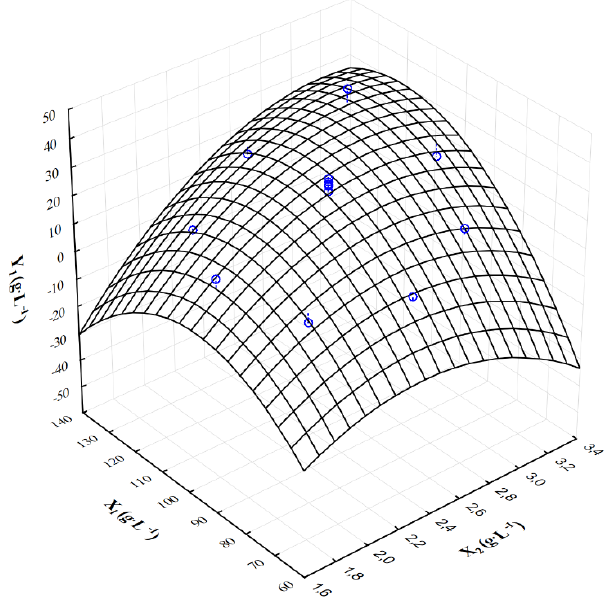
Figure 1. Response surface plot (3D) of the influence of the crude glycerol concentration (X 1 ) and ammonium nitrate concentration (X 2 ) on the final citric acid concentration (Y 1 ); blue points—points where the measurement was